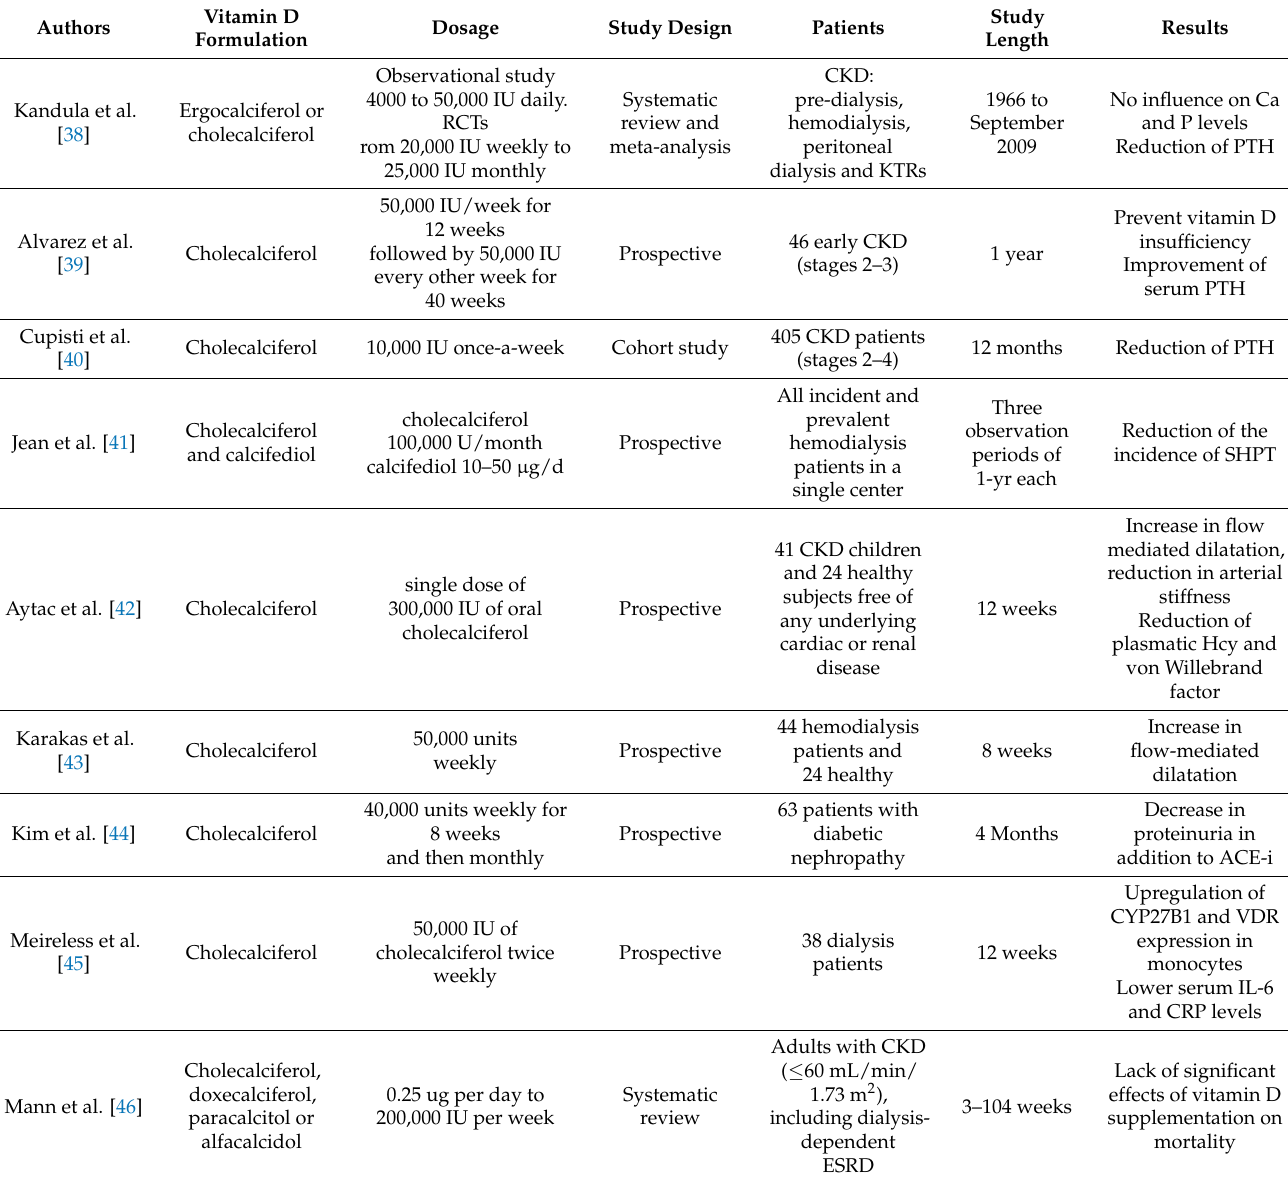
Table 1. Most representative studies on the effects of native vitamin D supplementation in the nephrology clinical